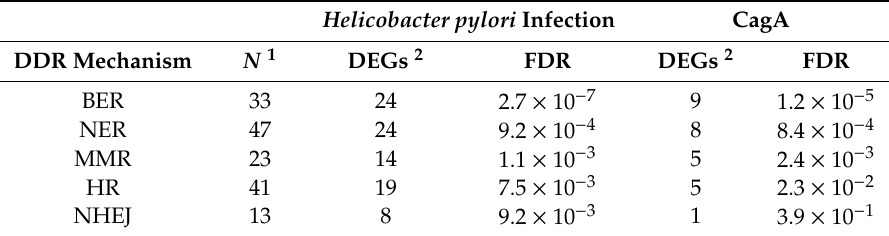
Table 1. Pathway enrichment analysis with regards to DNA damage repair (DDR) mechanisms.